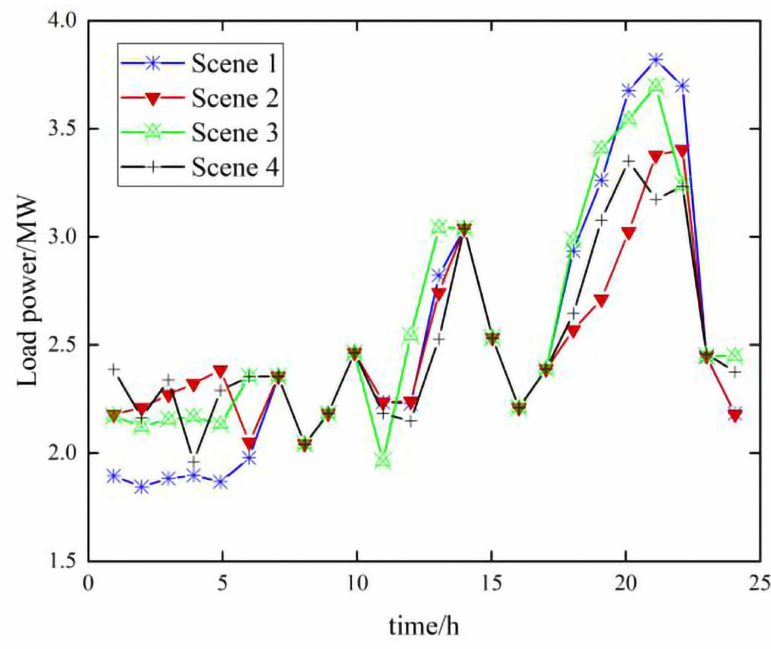
Figure 11. Load curve in different scenarios.